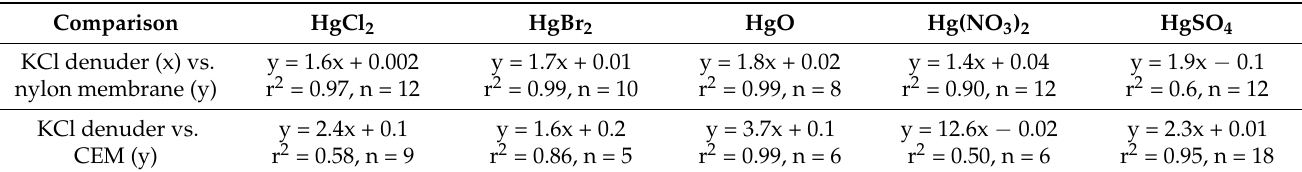
Table 1. Regression equations comparing GOM concentrations measured by nylon membranes or cation exchange mem- branes (CEM) versus those measured by the Tekran system denuder. GOM permeations were performed using the UNR laboratory manifold system and charcoal-scrubbed air. From Gustin et al. [53]. https://www.atmospheric-chemistry-and-